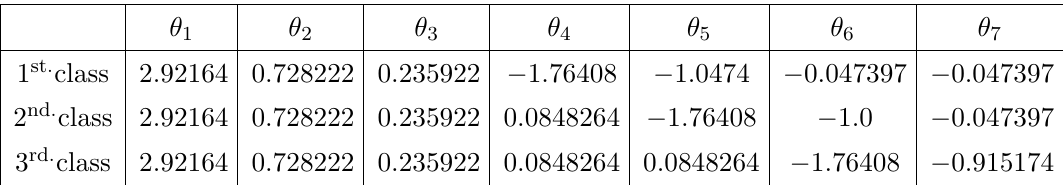
Table 2 . Critical exponents corresponding to the three classes of (cid:12)xed point exhibited in table